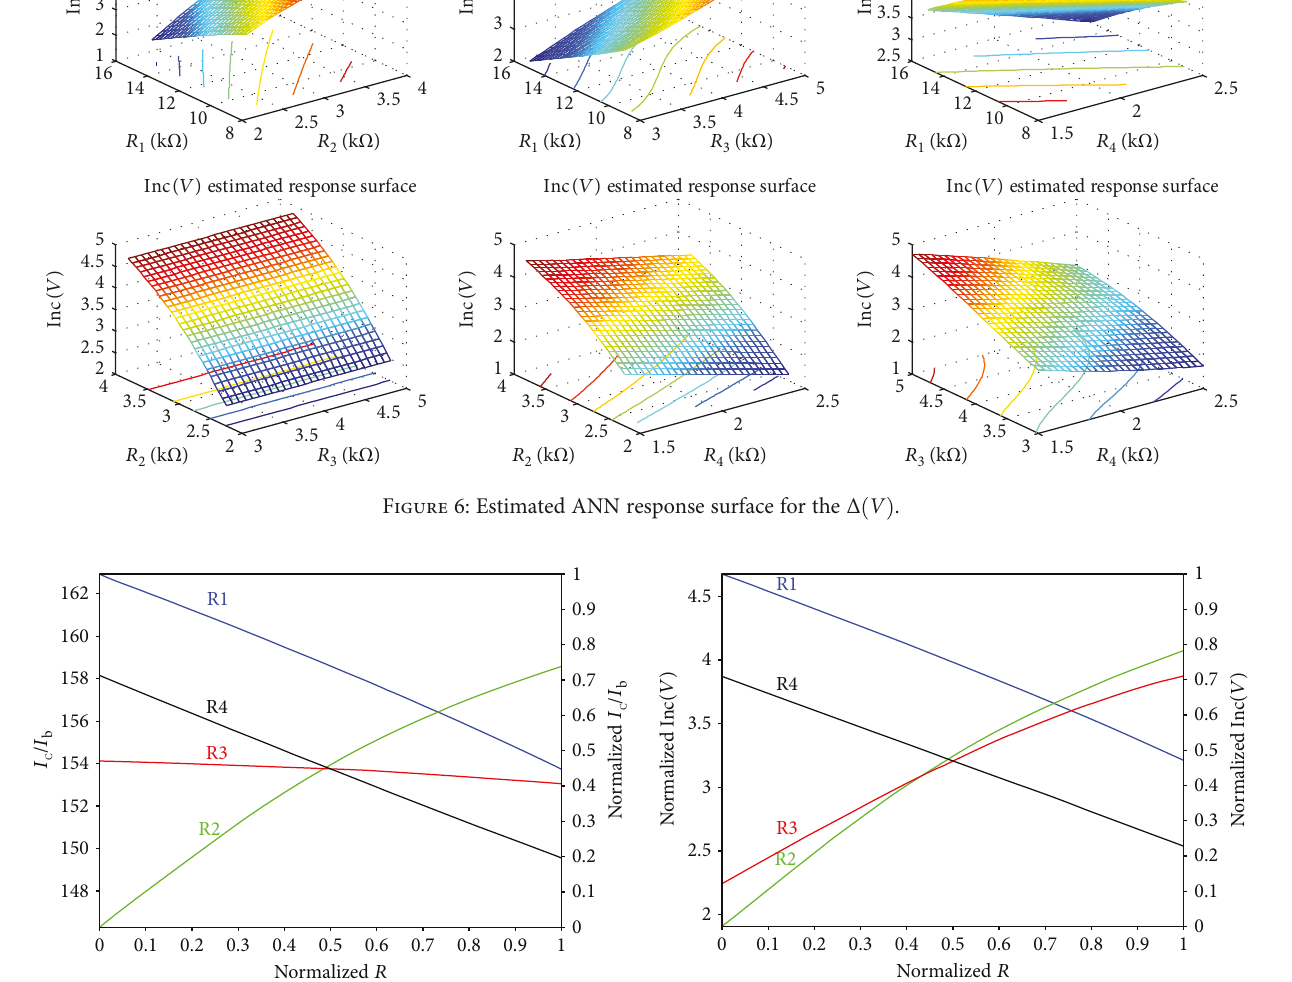
Figure 7: Main e ff ect plots showing the I